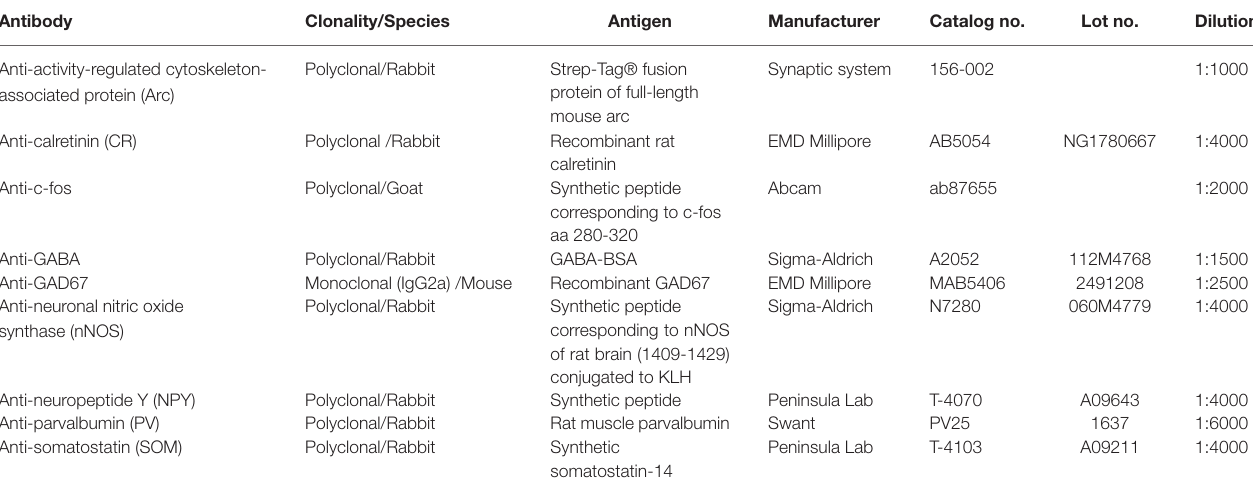
TABLE 1 | Information of primary antibodies